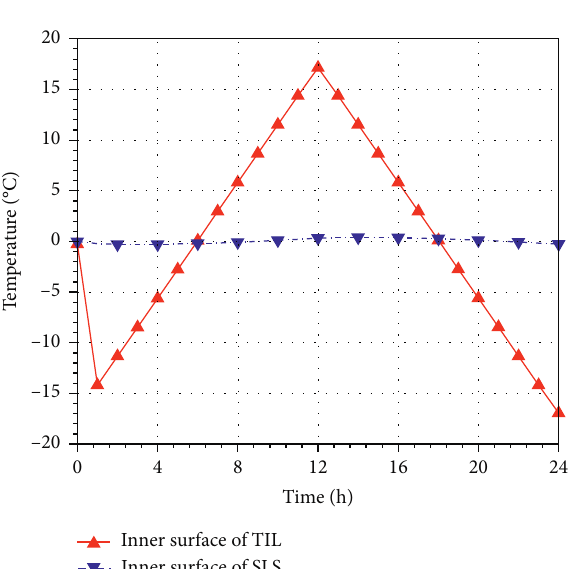
Figure 4: The variation of temperatures at inner surfaces of TIL and